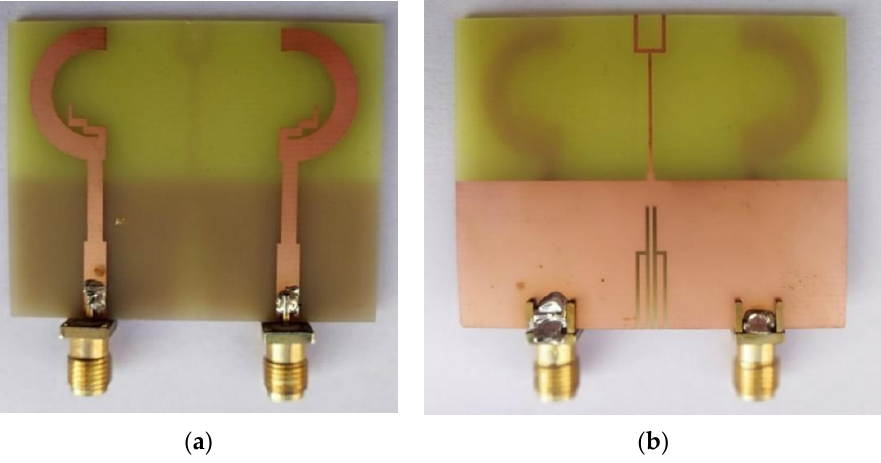
Figure 6. The actual picture of the antenna. ( a ) Top view; ( b ) bottom view.